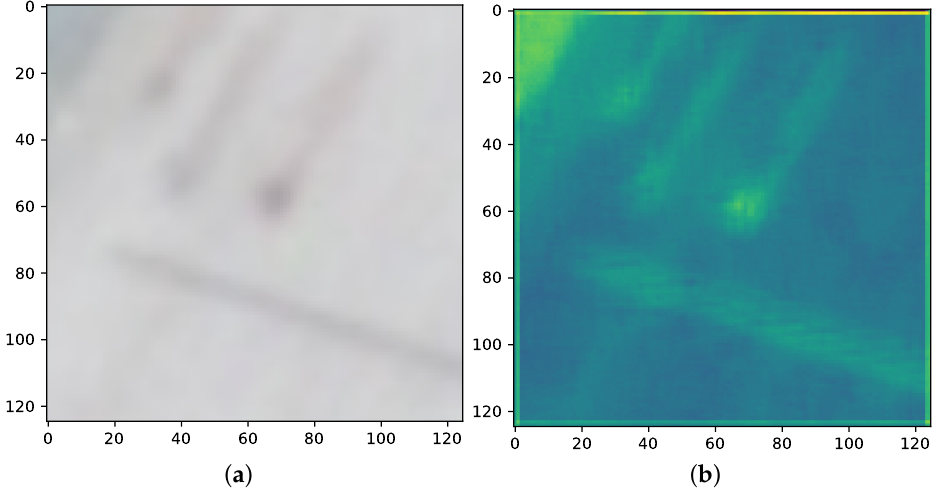
Figure 11. ( a ) An input image patch to the last convolutional layer of Stacked-DCFNetand and ( b ) its corresponding activation